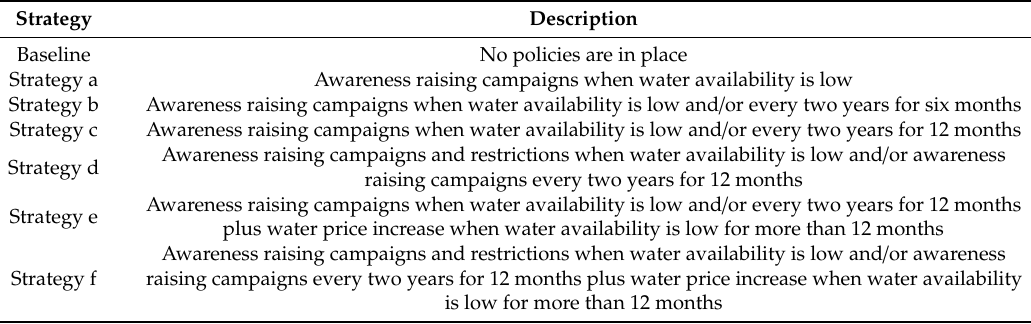
Table 1. Water demand management strategies under